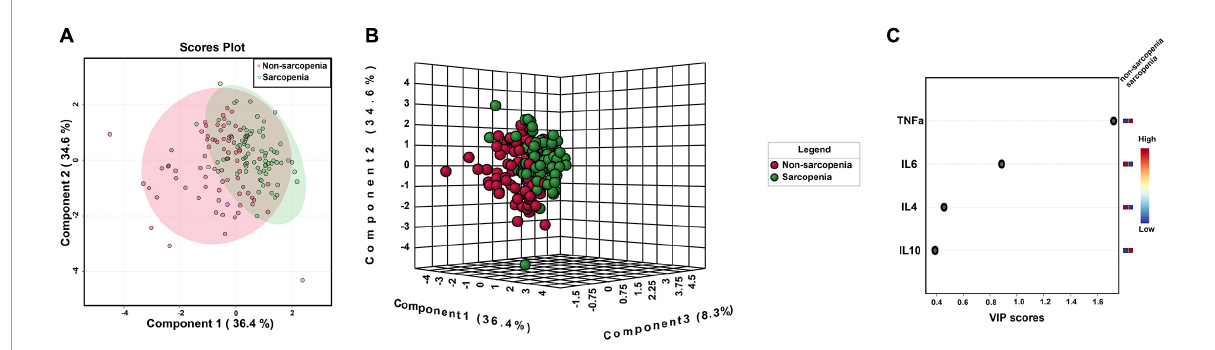
FIGURE3 PLS-DA model of serum inflammatory cytokines for sarcopenia. (A) 2D clustering of sarcopenia vs. non-sarcopenia groups ( n = 76 and n = 76, respectively) on PLS-DA; (B) 3D clustering of sarcopenia vs. non-sarcopenia groups ( n = 76 and n = 76, respectively) on PLS-DA; (C) VIP scores of inflammatory cytokines between sarcopenia vs. non-sarcopenia groups.